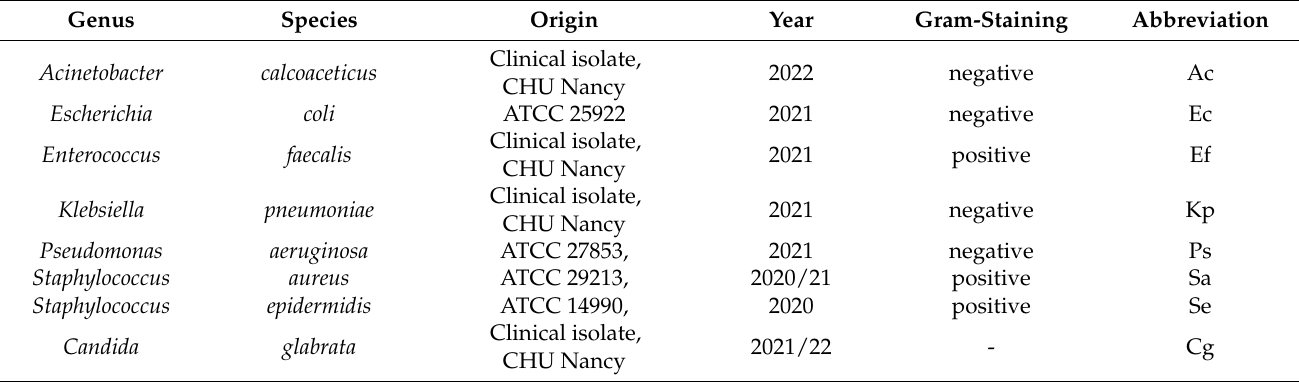
Table 2. Origin and Gram-staining information of experimental microorganisms.